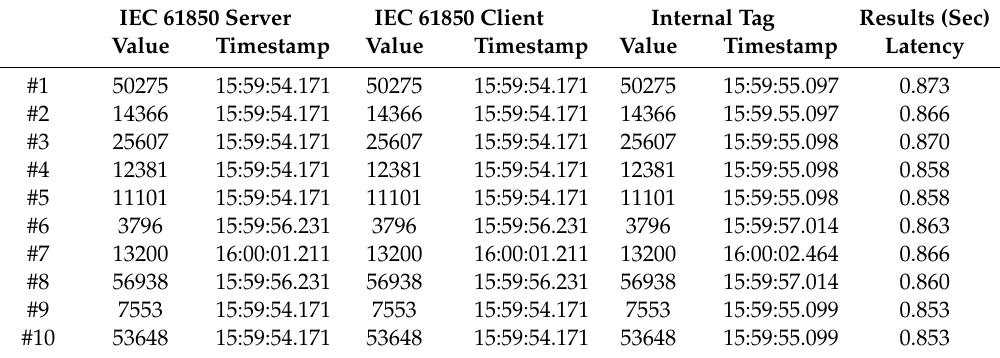
Table 4. IEC 61850 sequence of event transport values, quality and timestamps of SCADA tags.